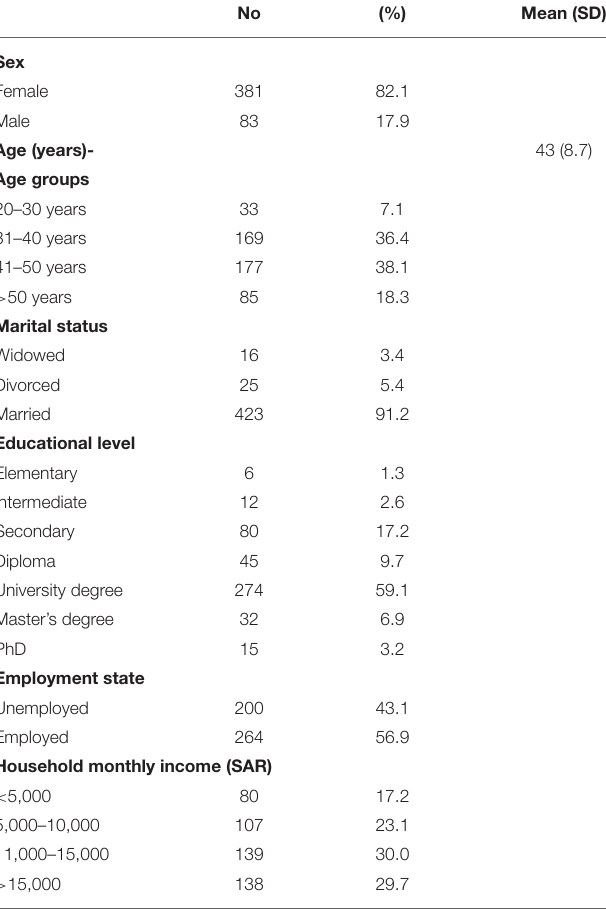
TABLE 1 | Distribution of the sociodemographic characteristics of parents ( N =